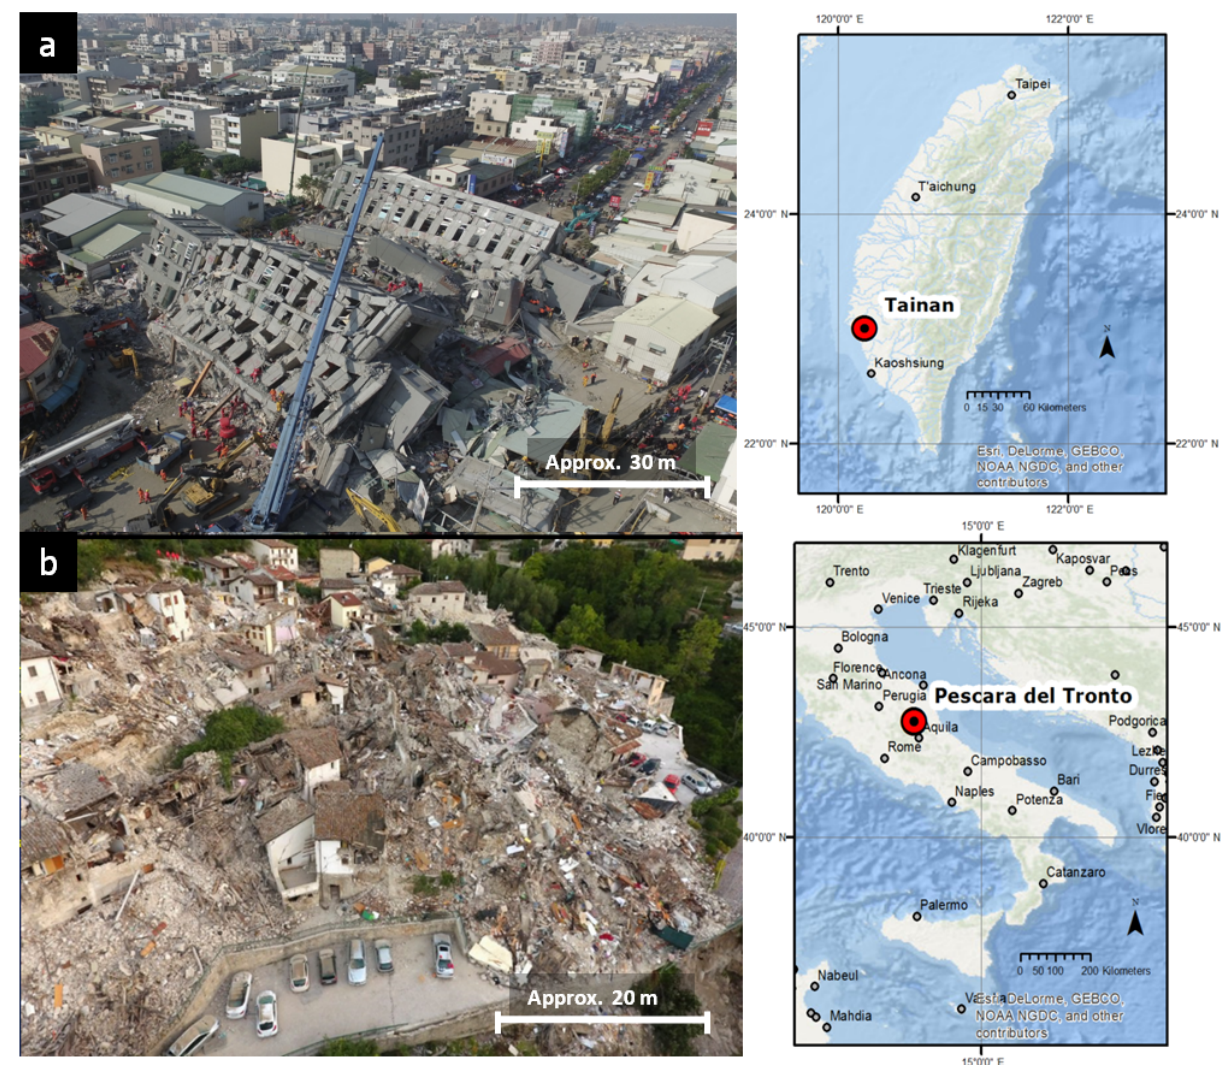
Figure 1. Study cases: (a) Taiwan earthquake, February 2016: flat terrain, smoke presence, and highly localized damage (Weiguan Jinglong collapsed building in the middle); (b) Pescara del Tronto earthquake, August 2016: hilly terrain and more diverse, widespread